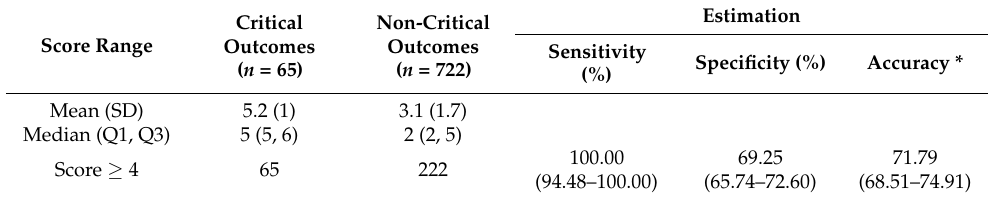
Table 5. Accuracy evaluation of the dengue critical scores from the external